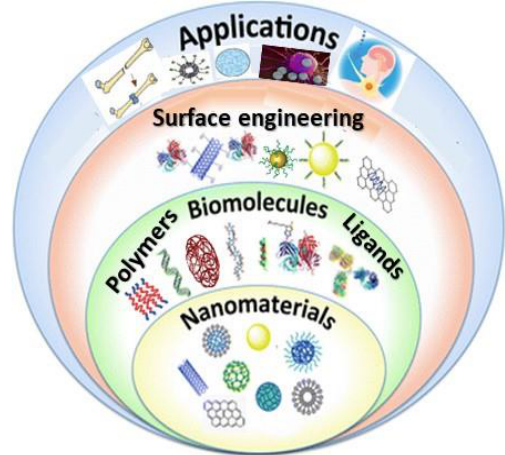
Figure 1. Schematic representation of the functionalization of different types of nanomaterials by polymers, natural biomolecules, and synthetic ligands, and their applications in nanomedicine.